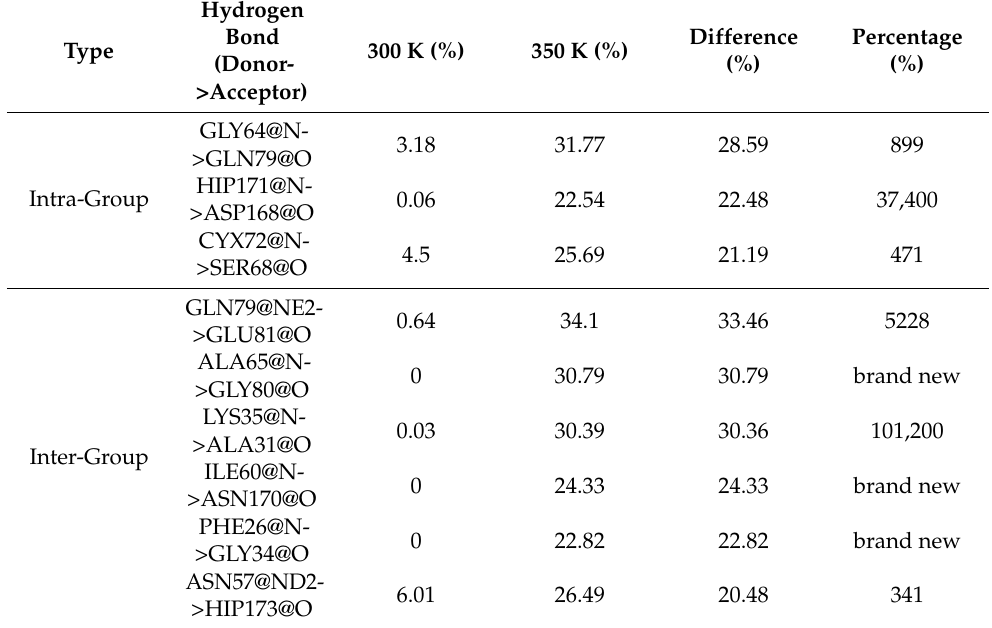
Table 1. The hydrogen bonds with a probability of not less than 20% after heating up in both the intra-group and inter-group as well as the difference and percentage of change between before and after heating